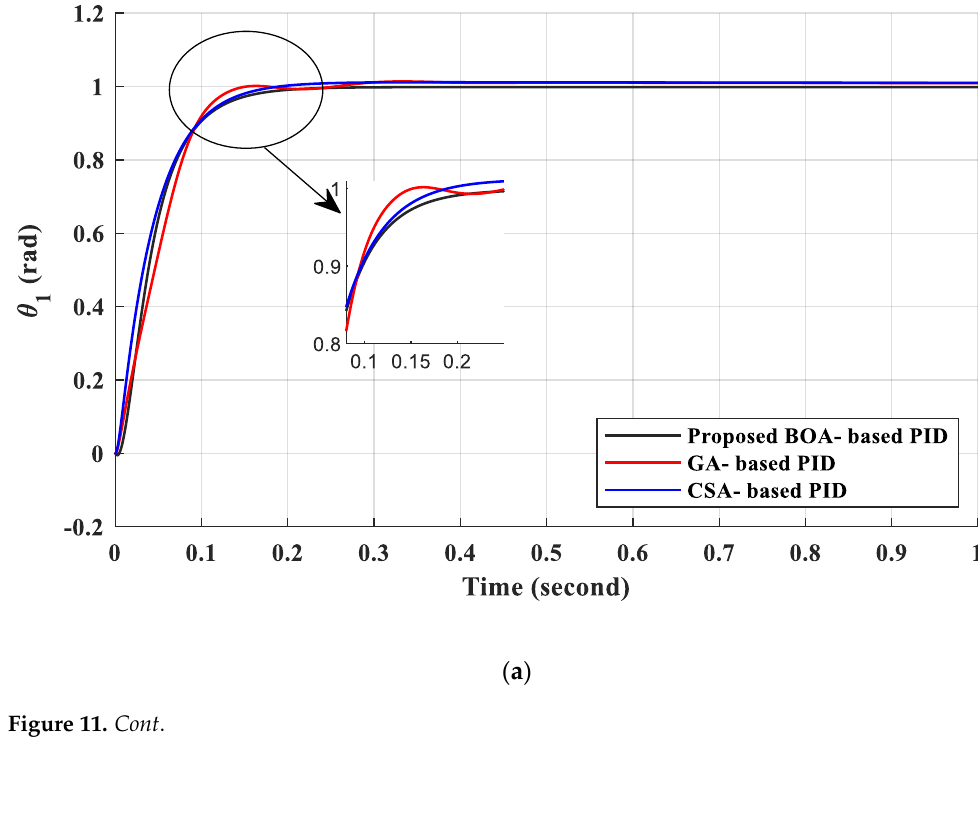
Figure 10. The output position due to link 2 in the case of cubic reference.